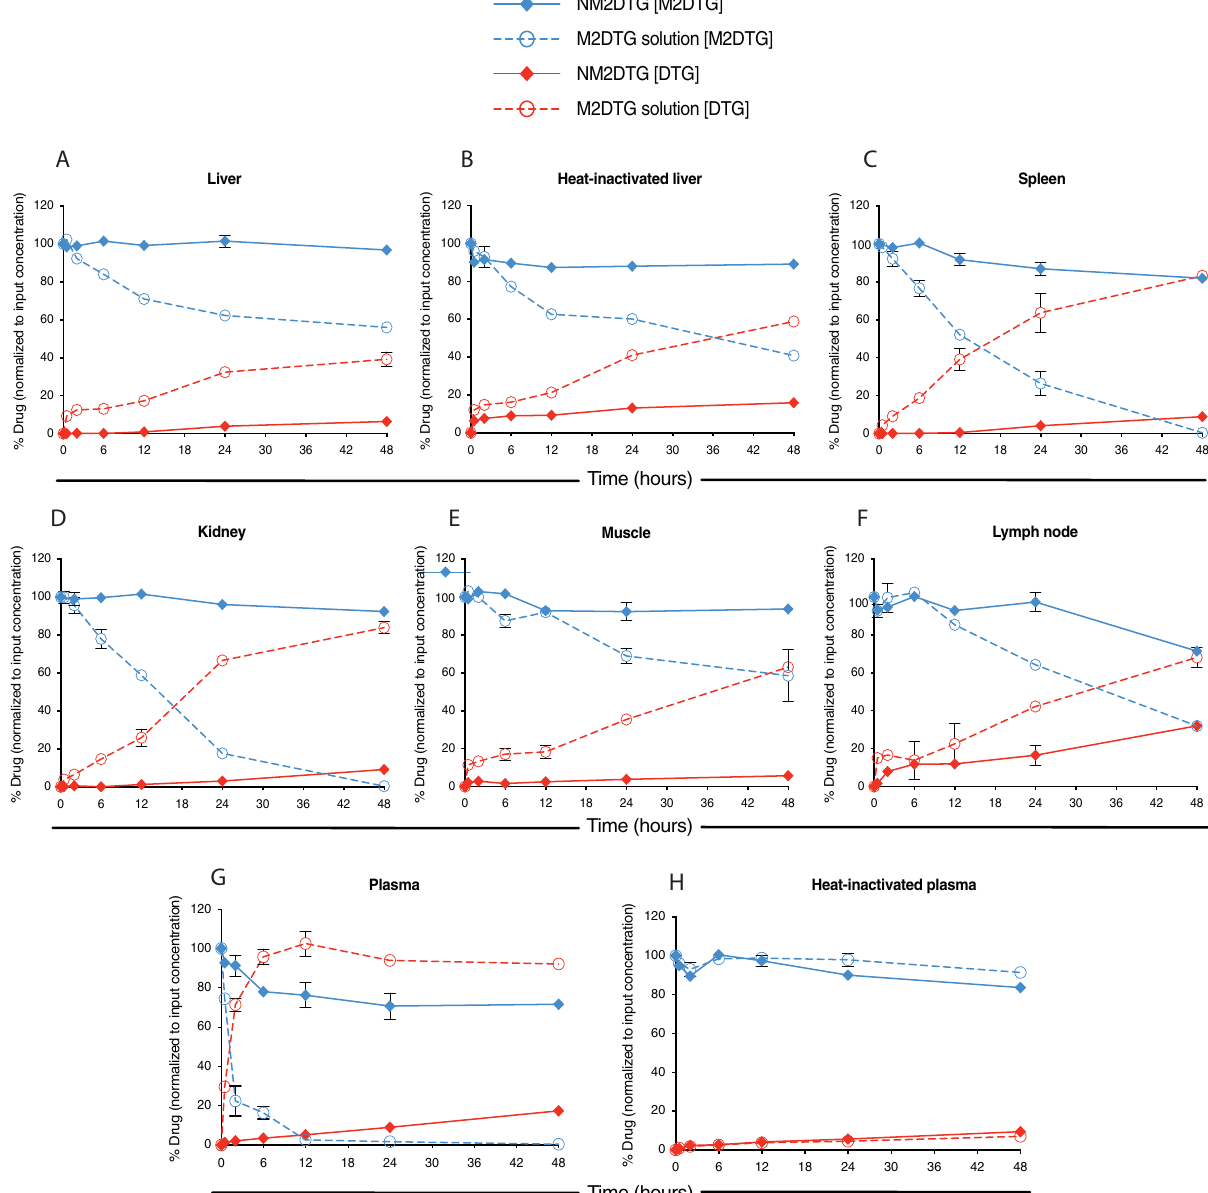
Fig. 5 Prodrug cleavage studies in tissue drug depots. Cleavage of M2DTG solution (dissolved in 1% (v/v) methanol; open circles) or NM2DTG nanoformulation (solid diamonds) in SD rat tissue homogenates ( A – F ) and plasma ( G – H ). Prodrug (M2DTG; blue lines) and parent drug (DTG; red lines) were quanti fi ed following M2DTG or NM2DTG incubation over 48 h in the A liver, B heat-inactivated liver, C spleen, D kidney, E muscle, F lymph node, G plasma, and H heat-inactivated plasma. All drug levels were quanti fi ed by UPLC-MS/MS. Results are expressed as mean ± SEM for N = 3 independent replicates ( N = 2 for lymph nodes due to limited sample). Source data are provided in the Figshare database under Digital Object Identi fi er (DOI) code https://doi.org/10.6084/m9. fi